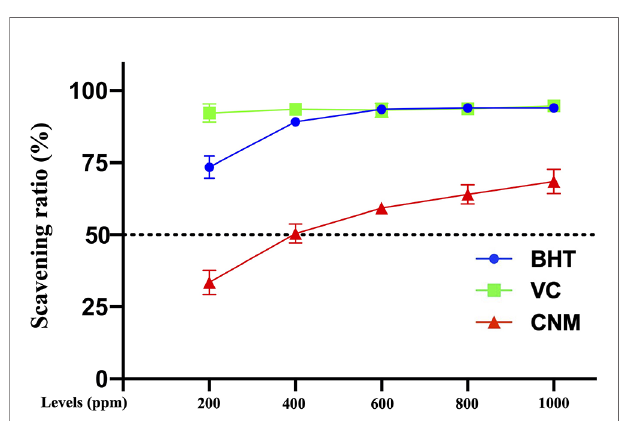
FIGURE 3 | The free radical scavenging ratio was determined by the DPPH method. CNMs at different MIC levels were mixed with DPPH solution. The mixtures were shaken well and put in the dark at room temperature for 30 min. Then absorbance was determined using a Q-6 UV-Visable Spectrophotometer at 517 nm. BHT and VC were used as positive control. Data are presented from two independent